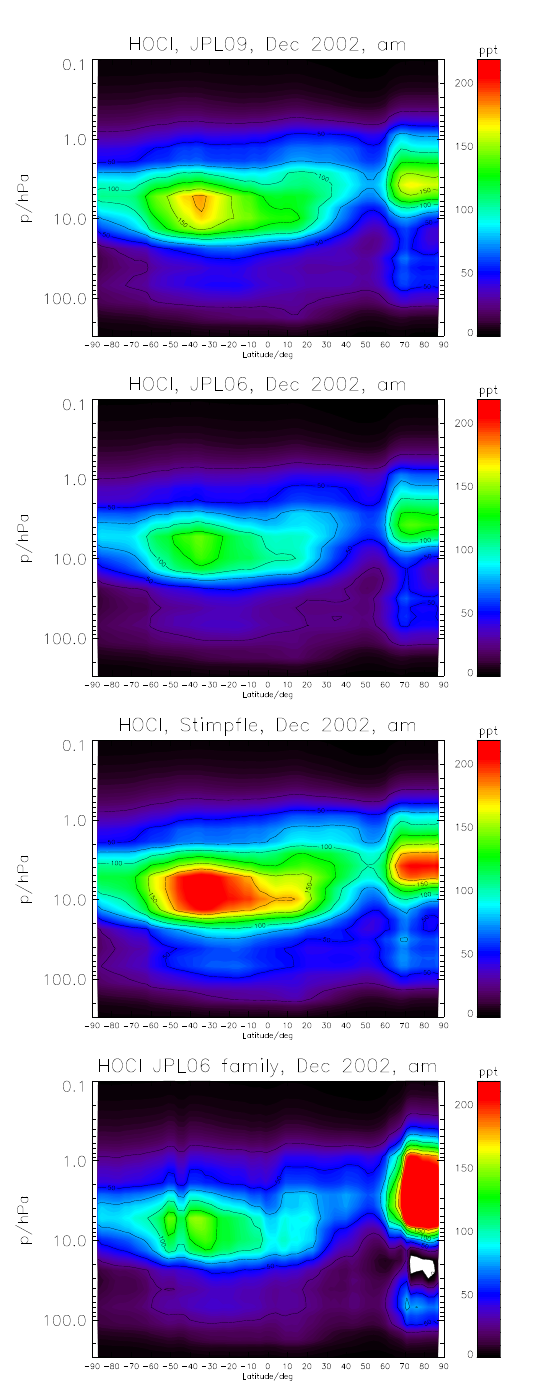
Fig. 3. Modeled mean HOCl distributions in December 2002 for different model setups: top three panels: explicit HOCl modeling and rate constants from JPL-2009, JPL-2006, and Stimpfle et al. (1979) (top to bottom); lowermost panel: EMAC in its default mode with family approach for HOCl and HOCl formation rate constant from JPL-2006. White areas in the model fields represent negative data caused by side wiggles of MIPAS averaging kernels.